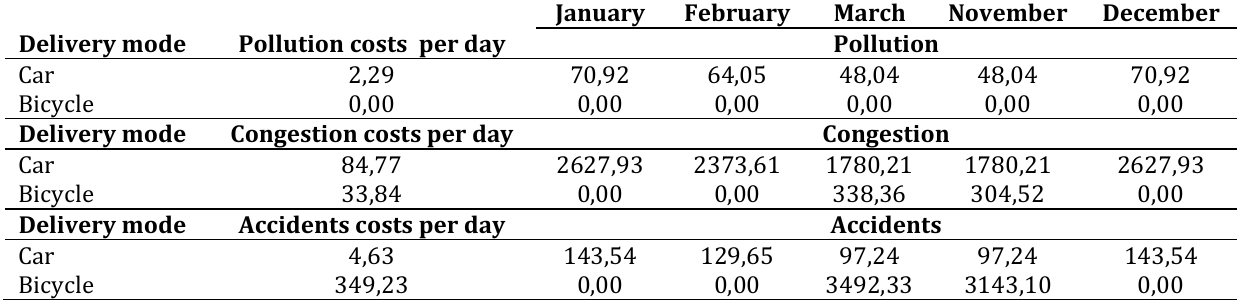
Table 12: External costs of combination “On-foot+Motorcycle” for season with difficult weather conditions Delivery mode